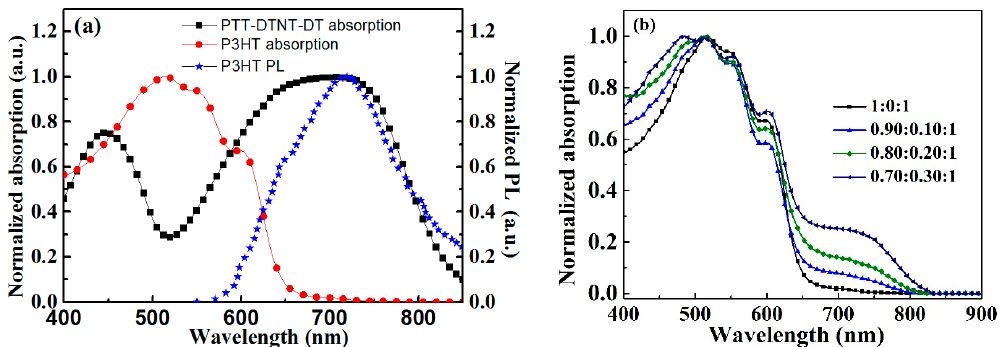
Figure 2. ( a ) Absorption of PTT-DTNT-DT film, Absorption and emission spectra of P3HT films; ( b ) Absorption of the blend films with different P3HT:PTT-DTNT-DT:PC 61 BM weight ratios.